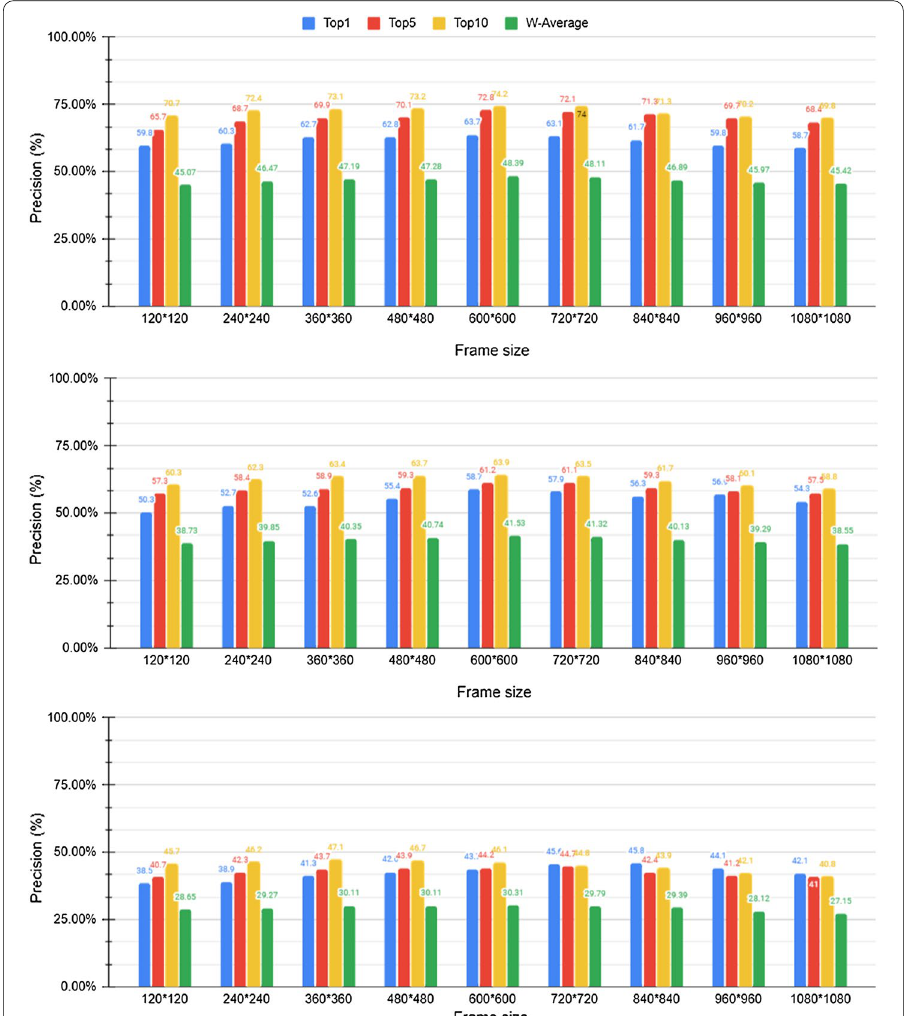
Fig. 10 Matching precision based on different frame sizes (%), Up: UCF11, Middle : UCF50, Down: HMDB51